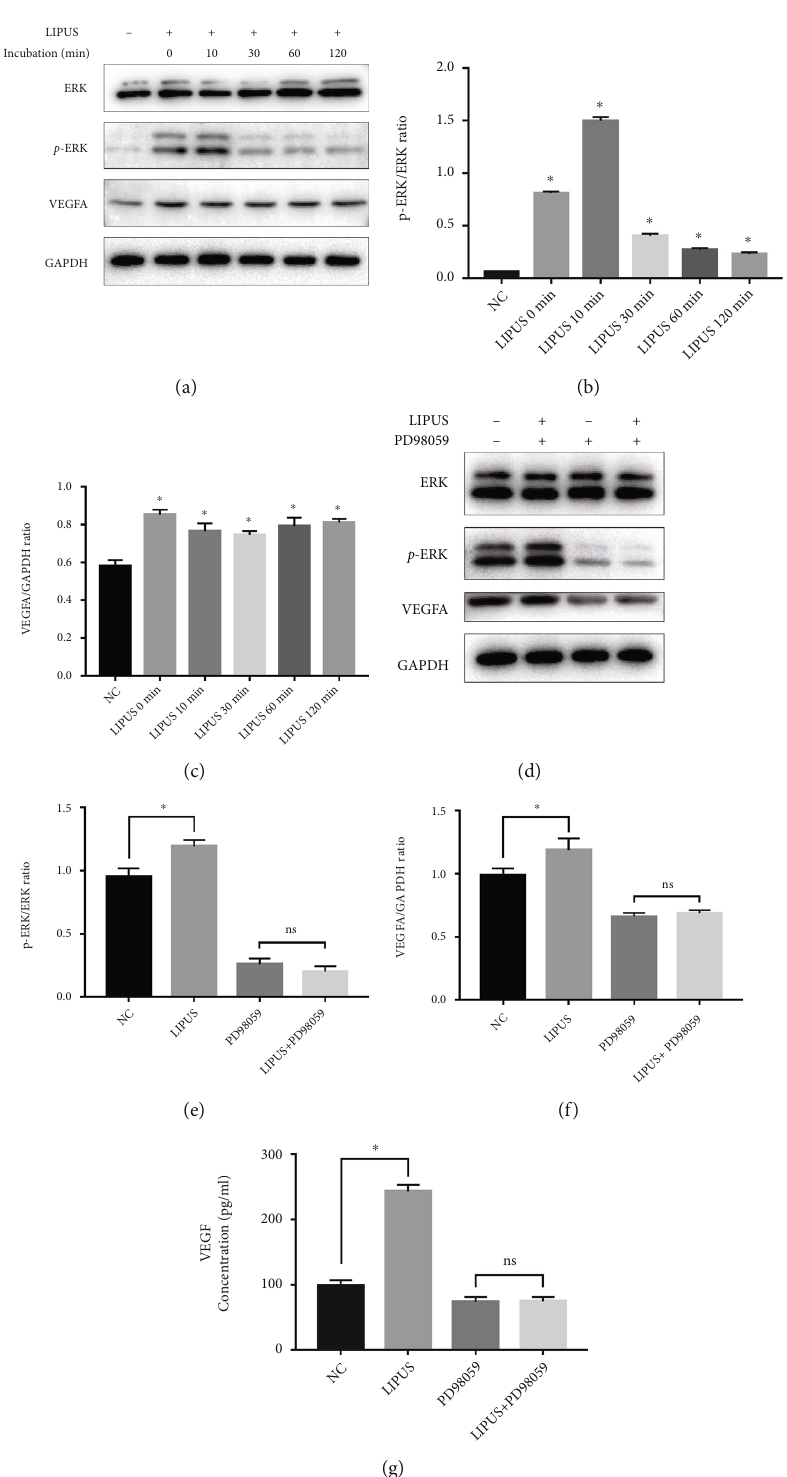
Figure 7: LIPUS activated the ERK-VEGFA pathway in ADSCs. (a) Western blot analysis of ERK, p-ERK, VEGFA, and GAPDH expression in ADSCs treated without or 0 minutes, 10 minutes, 30 minutes, 60 minutes, and 120 minutes after LIPUS stimulation. (b) The relative density of p-ERK compared with that of ERK. (c) The relative density of VEGF compared with that of GAPDH. (d) Western blot analysis of ERK, p-ERK, VEGFA, and GAPDH expression in ADSCs treated with LIPUS or PD98059, an ERK1/2 pathway inhibitor (ADSCs were pretreated with 80 μ M PD98059 for 1 hour). (e) The relative density of p-ERK compared with that of ERK. (f) The relative density of VEGF compared with that of GAPDH. (g) The concentration of VEGF in the supernatant of the cell culture medium. Data are presented as the mean ± standard deviation. ns p > 0 : 05 when comparing the PD98059 group. ∗ p < 0 : 05 when comparing the NC